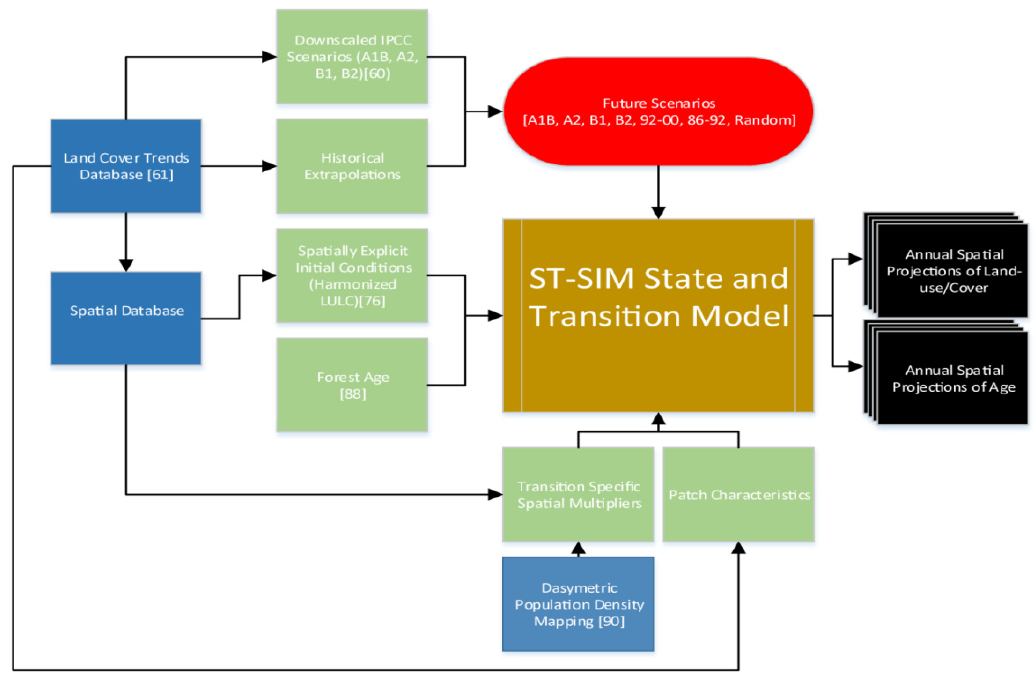
Figure 4. Conceptual diagram of the major components used in the ST-Sim modeling framework and model